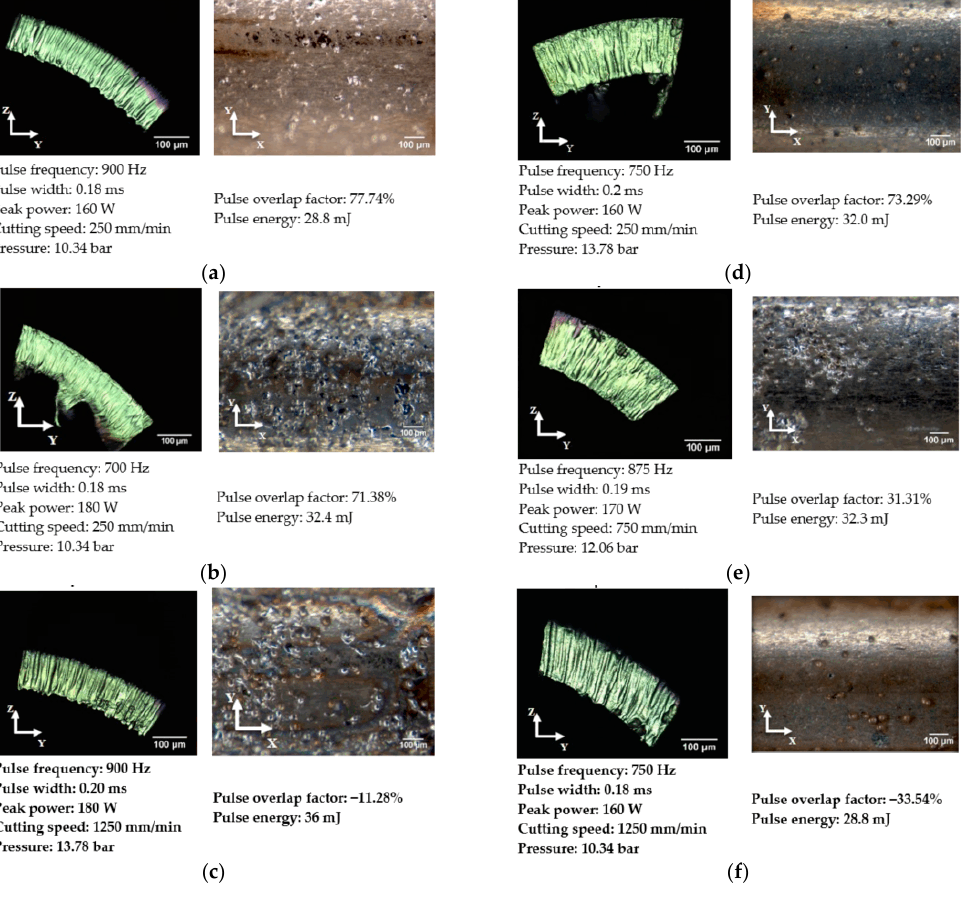
Figure 6. Average surface roughness and back wall dross images. ( a ) Ra < 1 μ m and Back Wall Dross < 3.5%. ( b ) Ra < 1 μ m and Back Wall Dross > 3.5%. ( c ) Ra > 1 μ m and Back Wall Dross > 3.5%. ( d ) Ra < 1 μ m and Back Wall Dross < 3.5%. ( e ) Ra < 1 μ m and Back Wall Dross > 3.5%. ( f ) Ra > 1 μ m and Back Wall Dross < 3.5% .